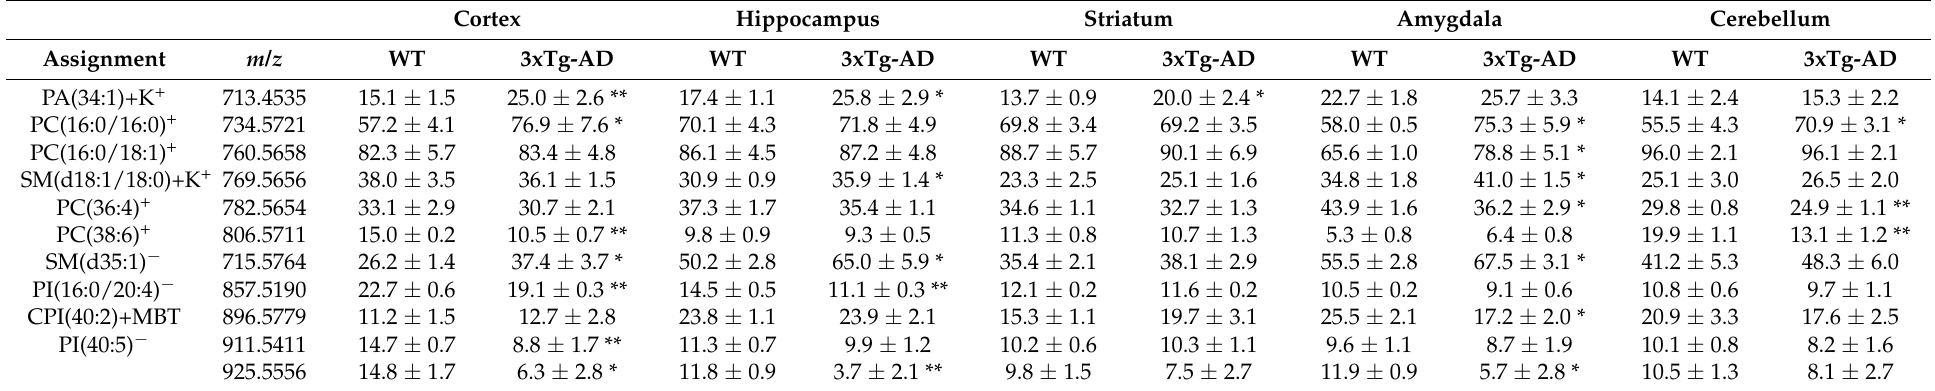
Table 4. Percentage of the intensity of molecular lipid species in positive and negative mode in sagittal mice sections from WT ( n = 6) compared to the 3xTg-AD ( n = 6), as revealed by MALDI-MSI. Data are mean ± SEM